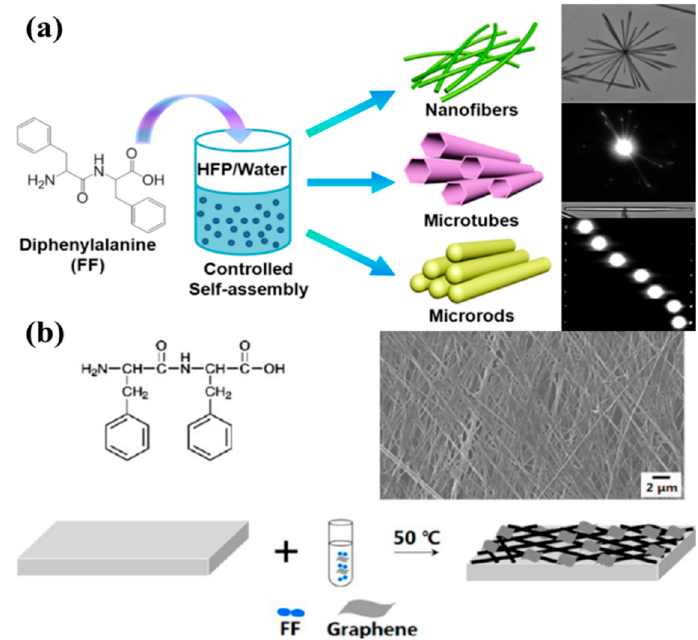
Figure 1. Hydrogen bonds promoted the self-assembly of biomolecules: ( a ) Hydrogen-bond-induced self-assembly of FF into nanofibers, microtubes, and microrods. Reprinted with permission from [21]. Copyright 2015 American Chemical Society. ( b ) The formation of microscale peptide nanowires (PNWs)–graphene array. Reprinted with permission from [52]. Copyright 2013 American Chemical Society.